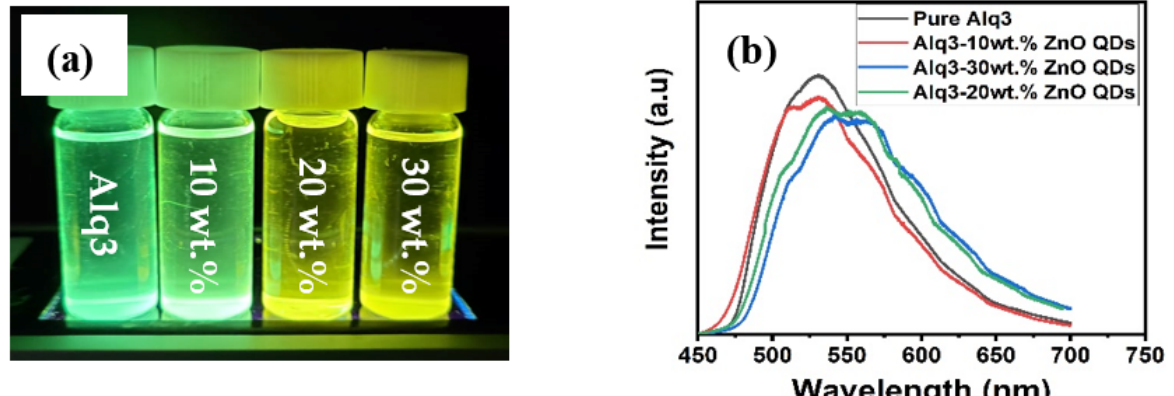
Figure 5. ( a ) Flurecence of pure Alq3 and Alq3-ZnO nanohybrids under UV excitation ( b ) PL emission spectrum.